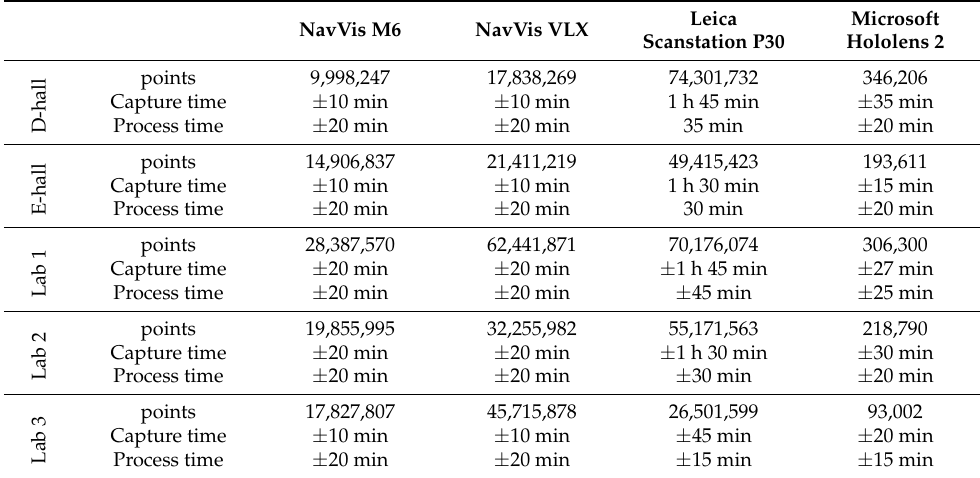
Table 3. Overview of the number of datasets and time needed with one person to capture and process the data. These times do not include the time needed to establish the TS-network. Leica Microsoft NavVis M6 NavVis VLX Scanstation P30 Hololens